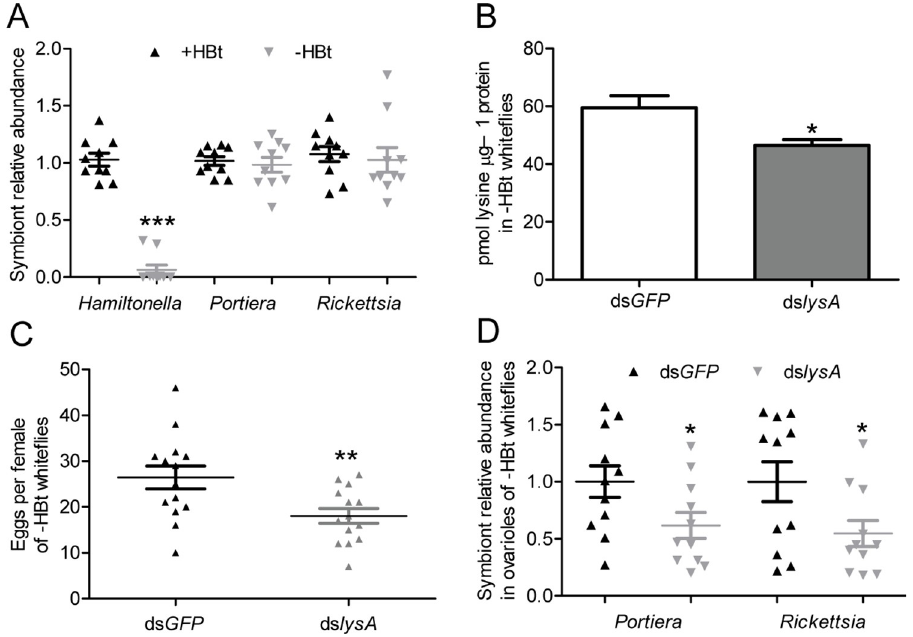
Fig 6. Effects of silencing horizontally transferred lysA on lysine levels, whitefly fecundity, and symbiont titer in whiteflies lacking Hamiltonella . (A) Effects of antibiotic treatments on the abundance of symbionts in B . tabaci . n = 10. (B) Lysine levels in Hamiltonella -cured whiteflies at day 3 after whiteflies were microinjected with ds lysA . n = 4. (C) Fecundity of Hamiltonella -cured female adult whiteflies at day 3 after microinjection with ds lysA . n = 14. (D) Effects of silencing horizontally transferred lysA on symbiont titer in ovarioles of Hamiltonella -cured whiteflies at day 3 after microinjection with ds lysA . n = 11. +HBt and -HBt represent Hamiltonella -infected and Hamiltonella -cured whiteflies, respectively. ds GFP and ds lysA represent ds GFP -injected and ds lysA -injected female adult whiteflies, respectively. Data are means ± SEM. The significant differences between treatments are indicated by asterisks ( � P < 0.05; �� P < 0.01; ��� P <